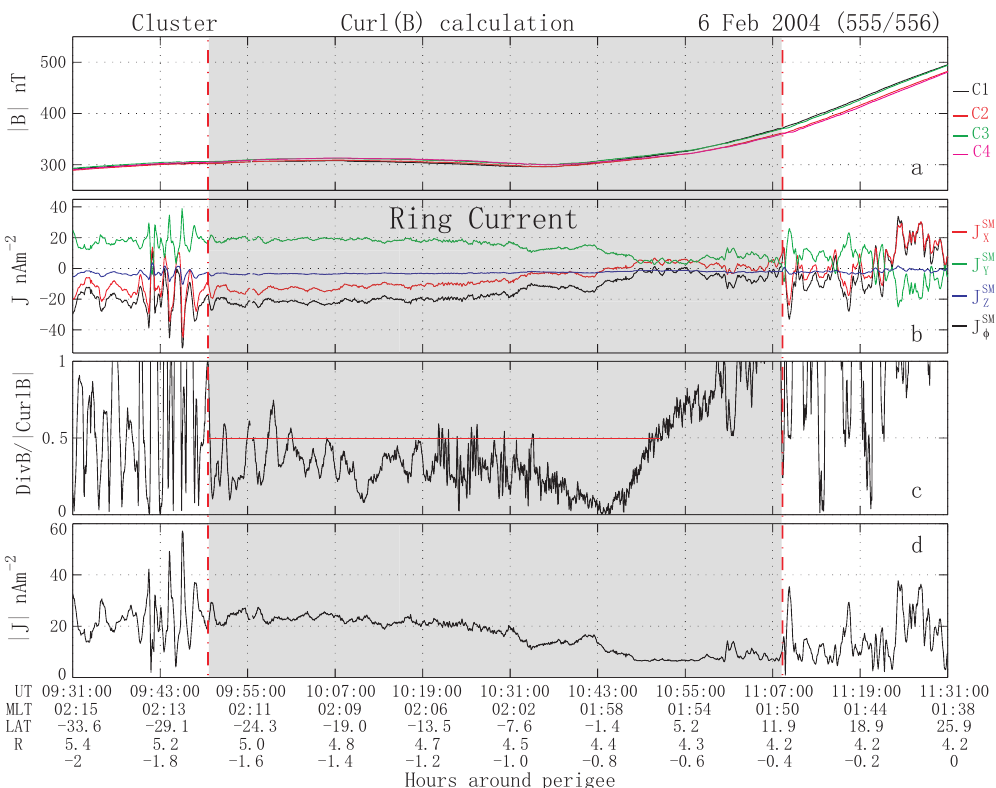
Fig. 2. An overview of the results calculated from 4 Cluster spacecraft technique (Curlometer) during 09:31 to 11:31UT on 6 February 2004: (a) the magnitude of magnetic field observed by 4 Cluster spacecraft, (b) the J X , J Y , J Z and J φ components of current density in cartestian and polar SM coordinates, (c) Div( B )/ | Curl( B ) | , and (d) the total current density.